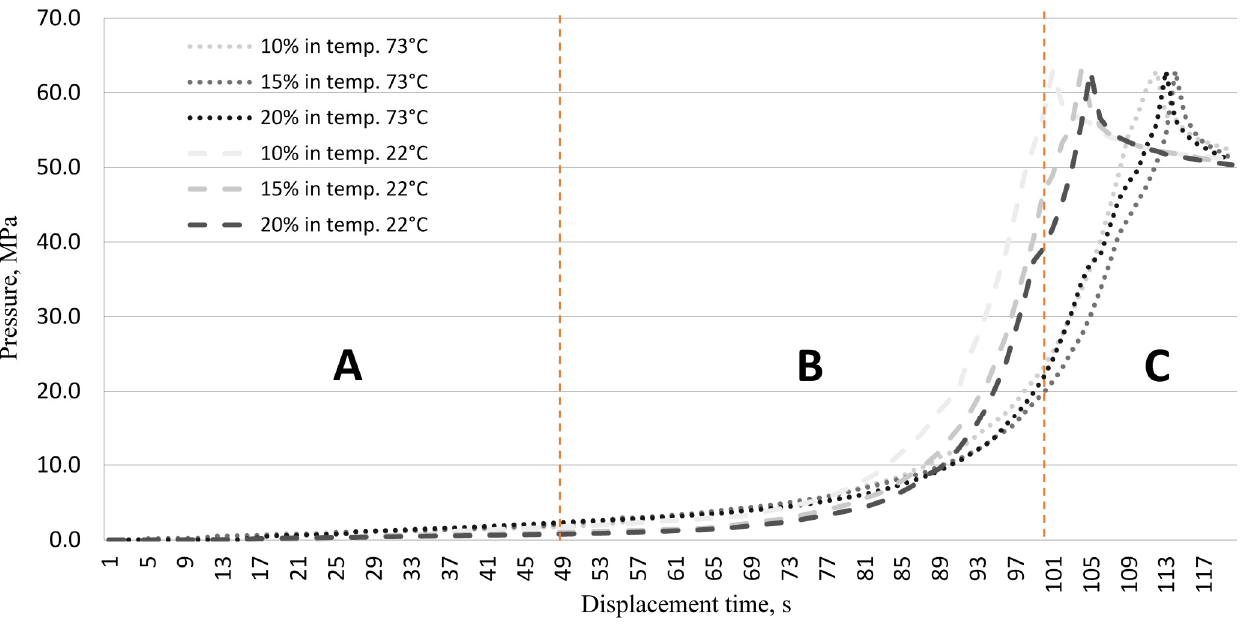
Figure 4. The resultant of strengths during the briquetting of the forest residue shredded chips at a temperature of 22 and 73 °C with a humidity of 10, 15, and 20%.